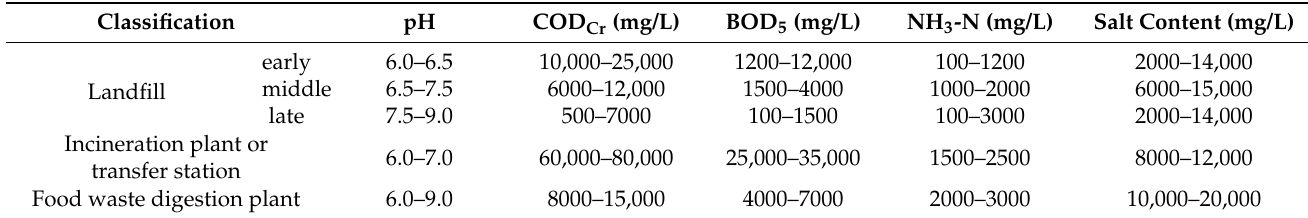
Table 5. Leachate characteristics from three different sources.